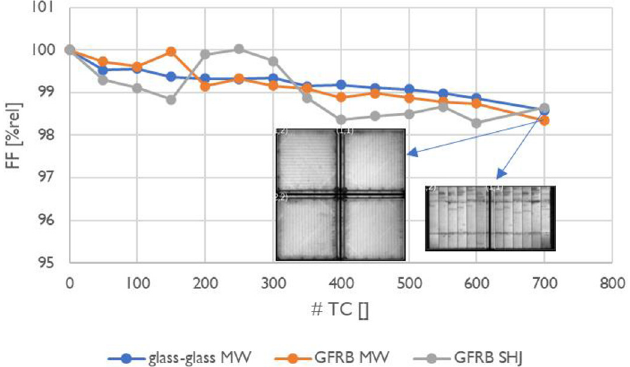
Fig. 10. Relative fi ll-factor degradation of GFRB laminates up until 700 cycles of GFRB laminates with multi-wire or shingled interconnection, compared to a glass-glass reference multi-wire laminate.